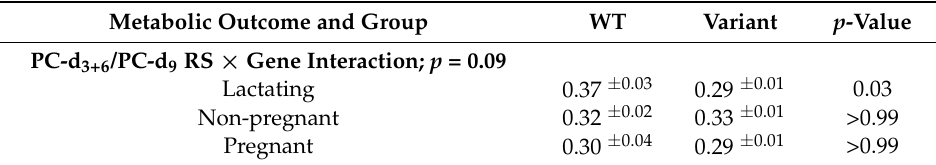
Table 12. PEMT rs7946 genotype alters the metabolic flux of choline-derived methionine  PEMT-PC in plasma. Values are least-squared means ± standard errors for each group in µM PC/study period.